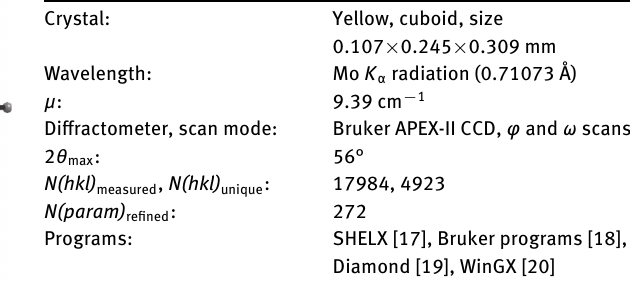
Table 1: Data collection and handling. Crystal: